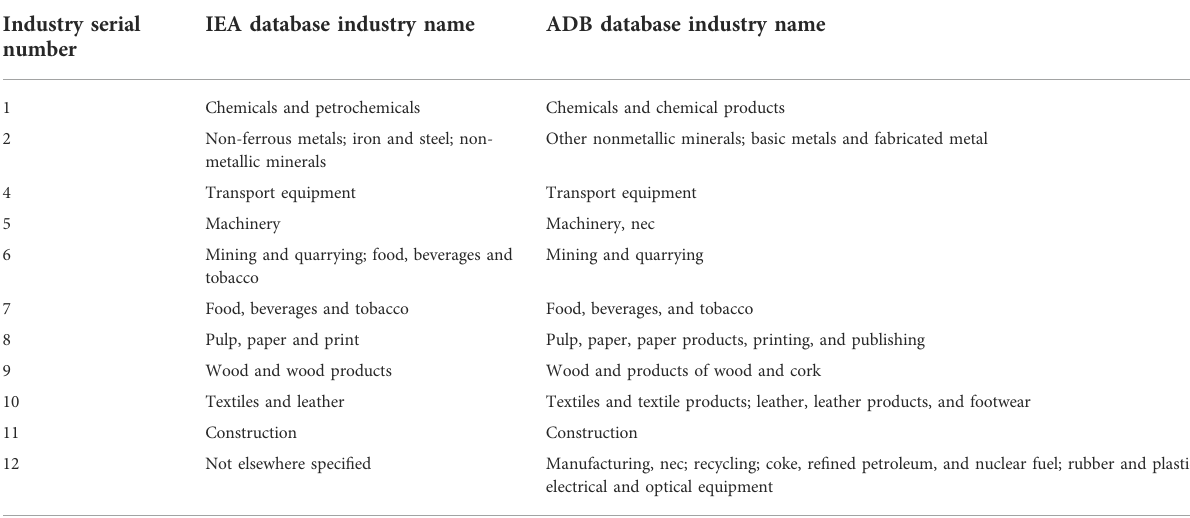
TABLE 1 ADB_IEA industrial sector matching table. Industry serial